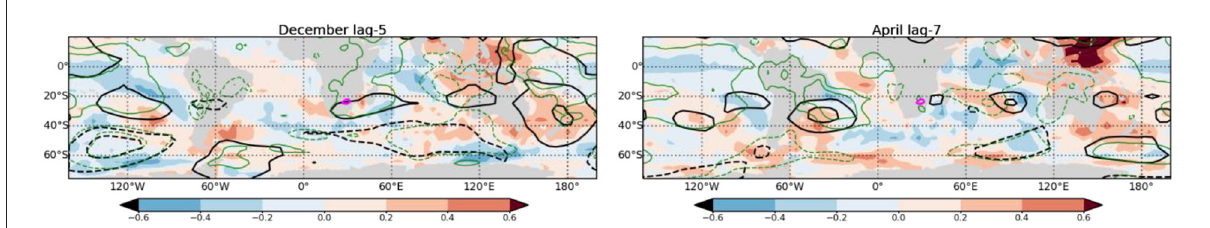
FIGURE8 Atmospheric teleconnections: 500-hPa (black contours) and sea level pressure (green contours) precursor to December (left) and April (right) malaria outbreaks are shown for − 5 months and − 7 months lags, respectively. Precursors are illustrated as correlations with solid and dashed contours (intervals of 0.2) for positive and negative correlations respectively. They are overlaid on SST precursors shown with red/blue shading. Correlations above 0.4 and below − 0.4 are significant at the 95% significance